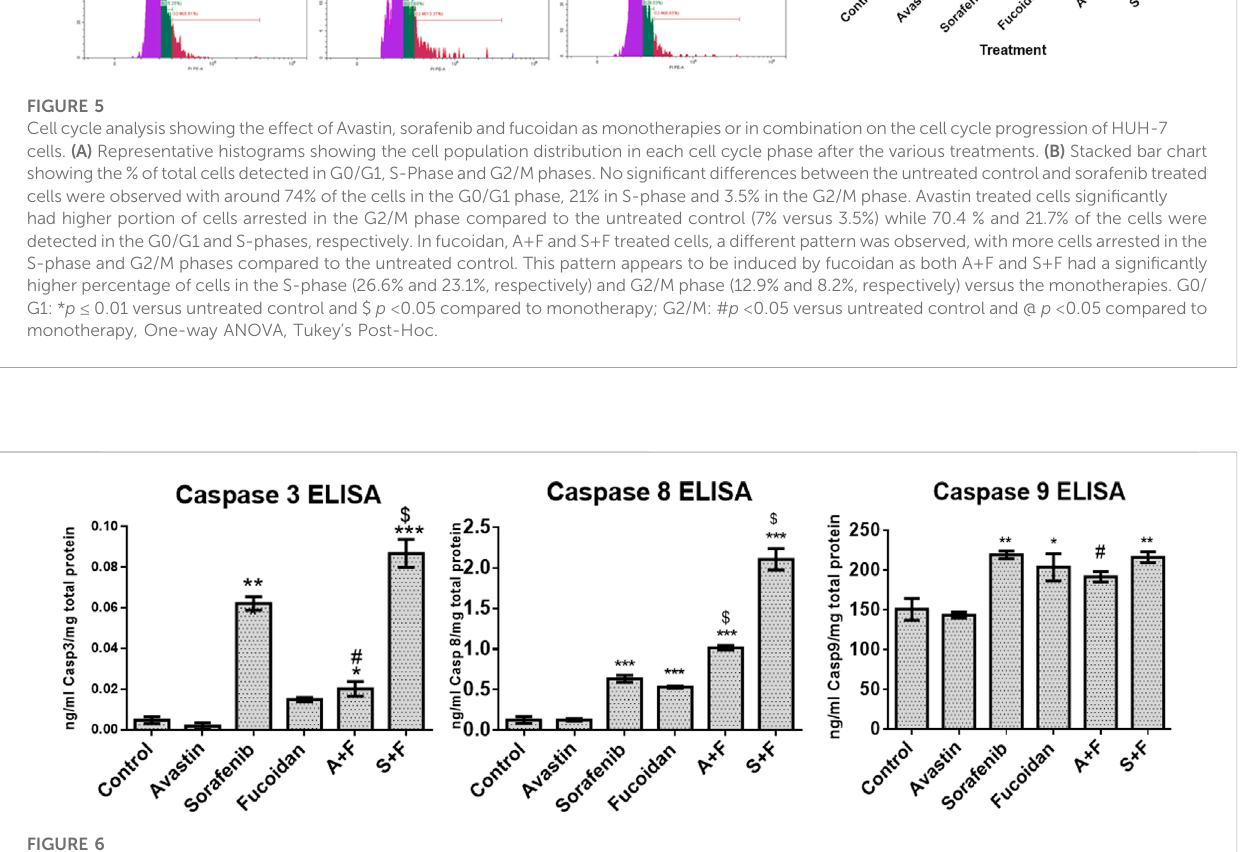
FIGURE 6 Caspase 3, 8, or 9 ELISA results done on HUH-7 whole cell lysates following treatment with Avastin, sorafenib and fucoidan as monotherapies or in combination.Resultsrevealedthatalldrugsandcombinations, exceptAvastinmonotherapy,signi fi cantlyincreasedthelevelsofcaspases3,8,and9with thehighesteffectobservedintheS+Fgroupforcaspase3and8.(n=3 – 4,* p < 0.05,** p < 0.005,*** p < 0.001 versus untreatedcontrolor $ p ≤ 0.005and # p < 0.05 compared to monotherapy, one-way ANOVA with Tukey ’ s post hoc